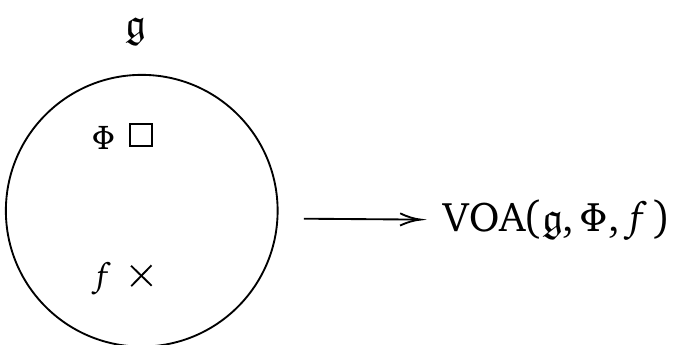
Figure 1: A mapping of a 6d ( 2,0 ) configuration to a 2d VOA, here g is a simple Lie algebra, Φ is an irregular singularity, and f represents a regular singularity. If Φ is of principal nilpotent type with type h ∨ and an integer label k [ 39, 58, 59 ] , the VOA is ∨ (cid:48) ( g , f ) with k (cid:48) = − h ∨ + h just W -algebra W k h ∨ + k